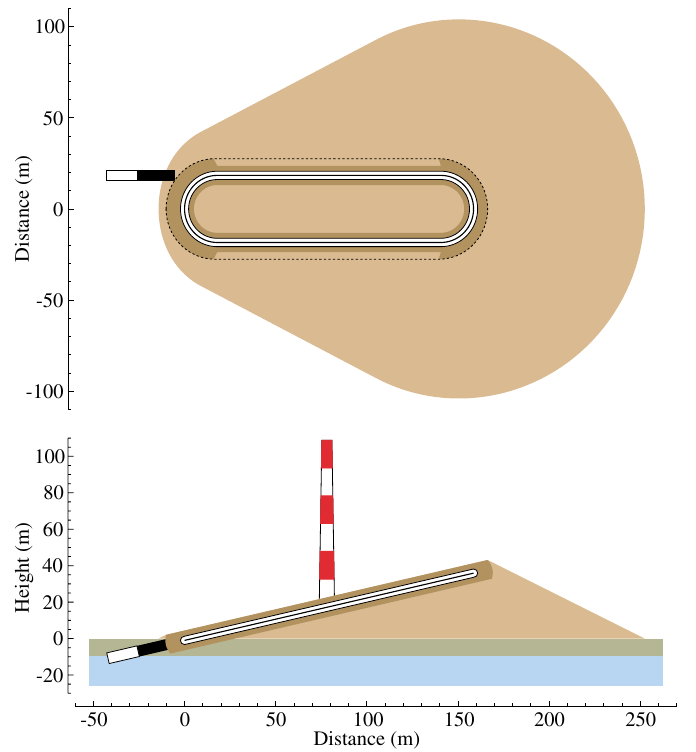
FIG. 25. (Color) Top view and cross section through 20 GeV ring and berm. The existing 110 m tower, drawn to scale, gives a sense of the height of the ring on the BNL